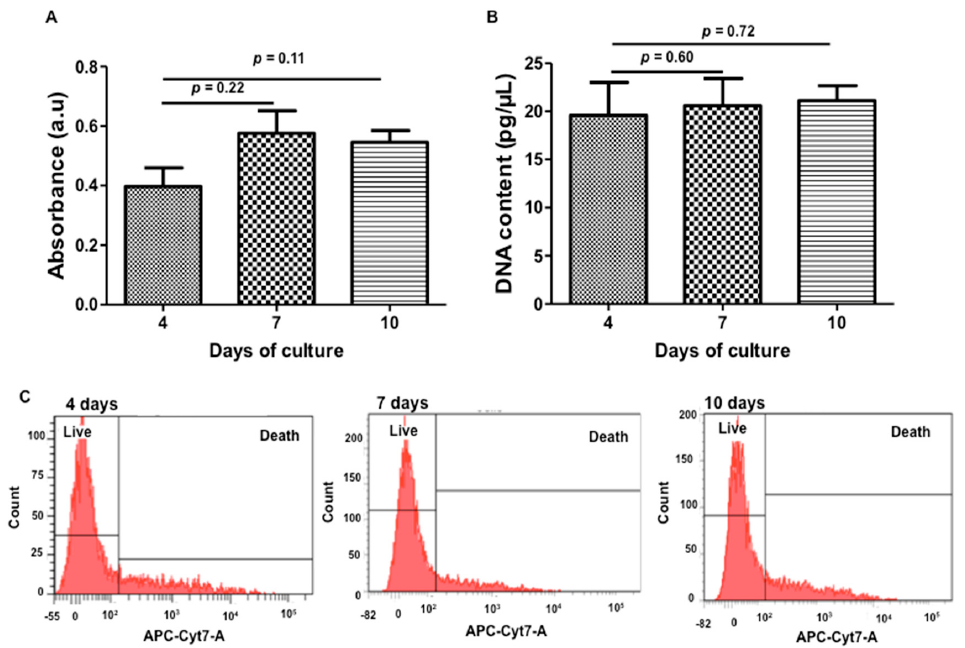
Figure 4. Cell viability over the time of the study. ( A , B ): Histogram reflecting WST-1 assay and DNA quantification, respectively; and ( C ): Flow cytometry results obtained after Zombie ® labelling. Kinetic study performed after 4, 7, and 10 days of culture showing live and non-proliferating WJ-MSCs cultured within HEMOCOLLAGENE ® foam ( n = 6, Mann and Whitney test).